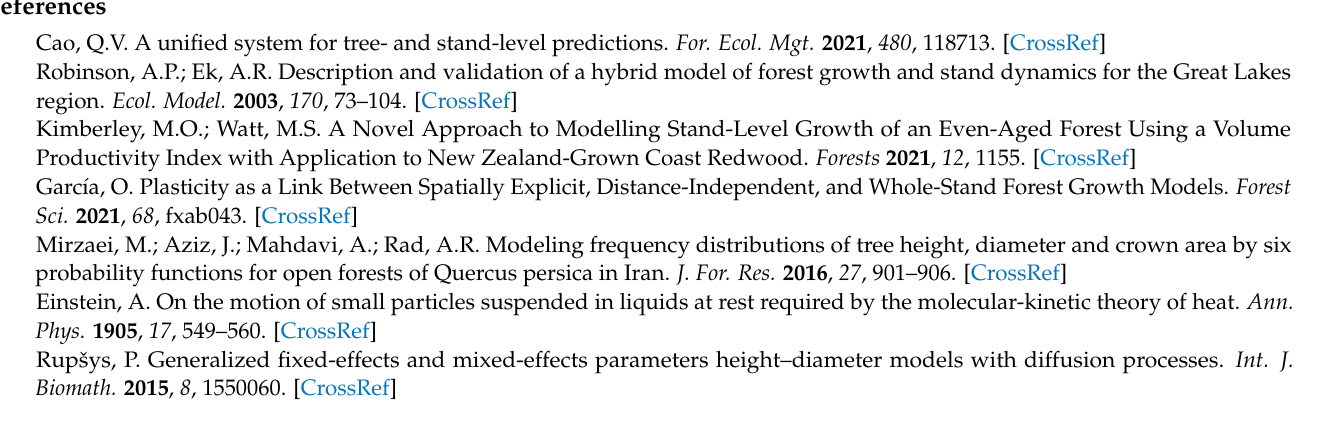
Figure A3. Estimated marginal probability density functions of the height for two randomly selected stands from a validation dataset: ( left ) first stand; ( right ) second stand; ( 1st row ) all species; ( 2nd row ) pine ( Pinus sylvestris ); ( 3rd row ) spruce ( Picea abies) ; ( 4th row ) silver birch ( Betula pendula Roth and Betula pubescens Ehrh.); black — 30-year-old stands; red — 70-year-old stands; and blue — 120-year-old stands.